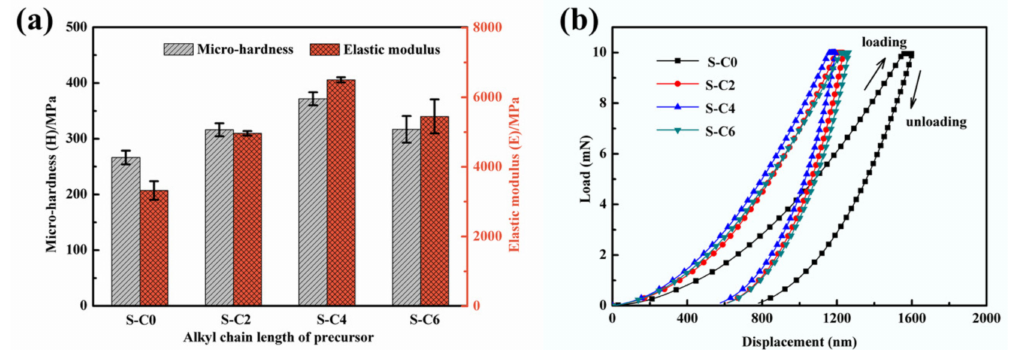
Figure 4. E ff ect of the in situ synthesized Ag 2 S nanoparticles on mechanical properties of the nanocomposite coatings, ( a ) micro-hardness and elastic modulus, ( b ) load-displacement